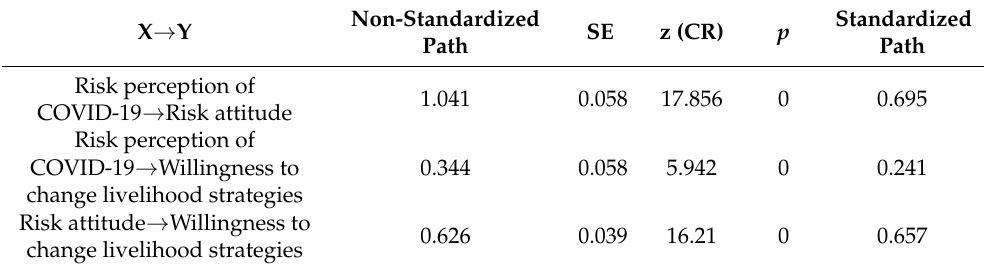
Table 4. Path coefficients.